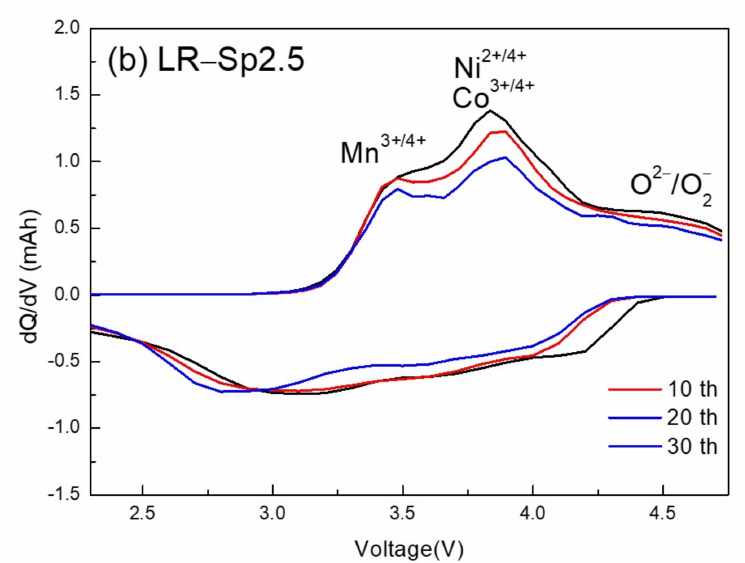
Figure 12. Differential capacity curves of ( a ) LR–Bare and ( b ) LR–Sp2.5 cathodes for the 10th, 20th, and 30th